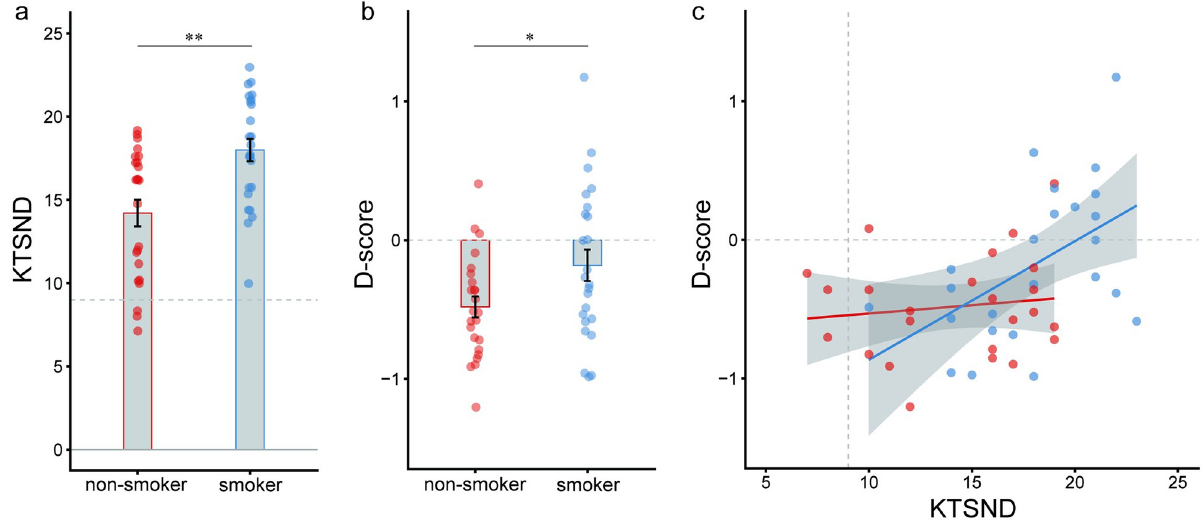
Fig 2. The right panel depicts the group difference of the KTSND score, the center panel depicts the group difference of SC-IAT D-score, and the left panel depicts the difference of correlation between KTSND and SC-IAT D-scores. Nonsmokers data is shown in orange and smokers’ in blue. Error bars indicates a standard error and grey dashed line indicates the boundary that distinguishes between the positive and negative attitude toward smoking. KTSND: Kano Test for Social Nicotine Dependence. � p < .05, �� p < .01.